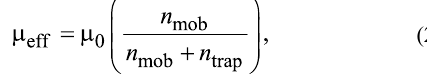
At voltages below 2 V the low charge injection region can